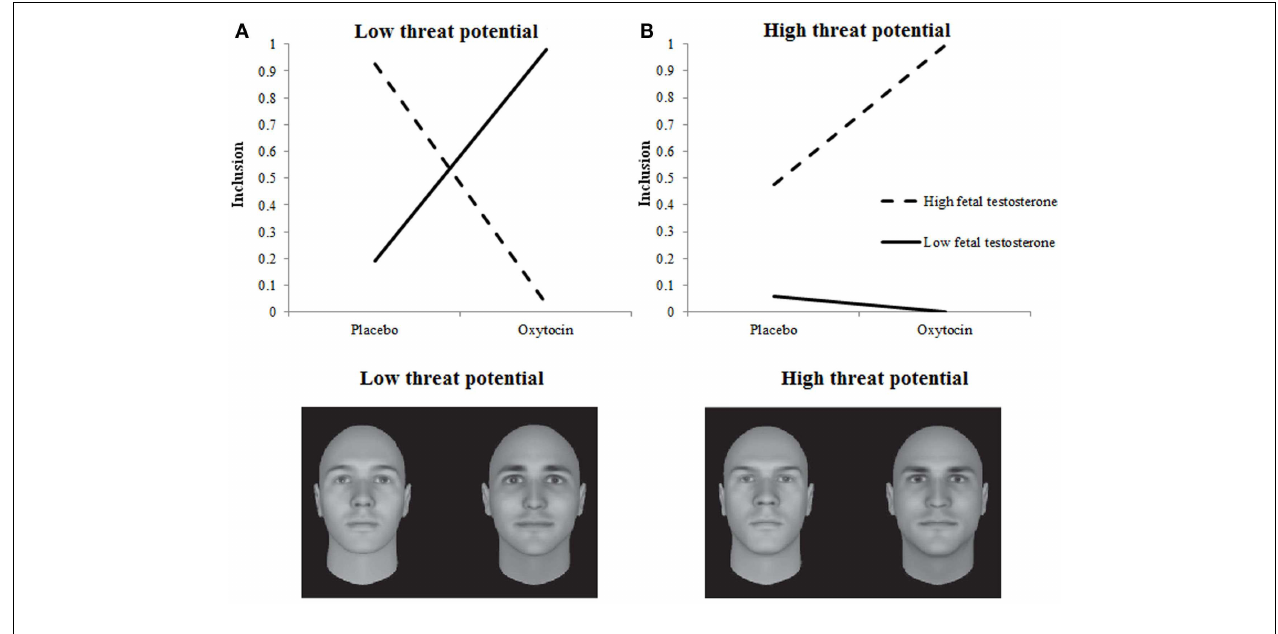
rather than placebo. Fetal testosterone vs. estradiol prenatal priming ratio was included as a continuous variable in our model. For visualization purposes, we plotted the interaction with this continuous variable centered once at + 1 SD (dotted lines) and once at − 1 SD (solid lines).